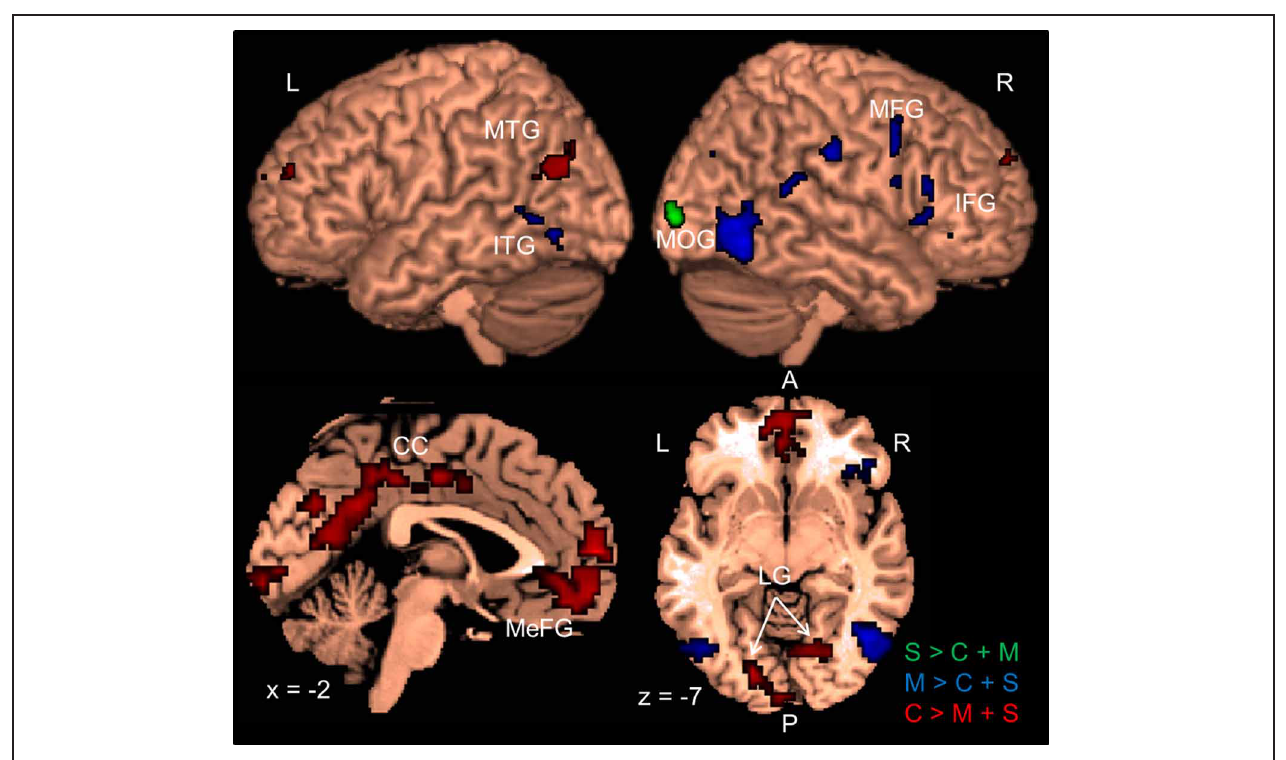
FIGURE 2 | Results of the whole-brain group-analysis ( N = 12) for the Garner task averaged across change and no-change blocks. Areas are significant at p < 0 . 05, FDR-corrected at the cluster level for multiple comparisons across the whole-brain. Slice numbers are in MNI space. L, left;